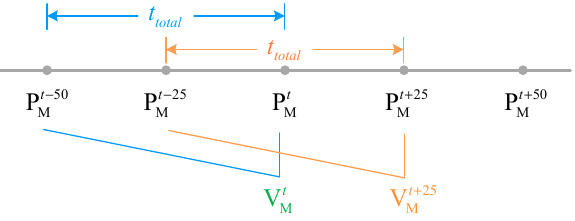
Figure 8. Aircraft activity differentiated according to its speed of movement. Figure 9. Aircraft activity differentiated according to its speed of